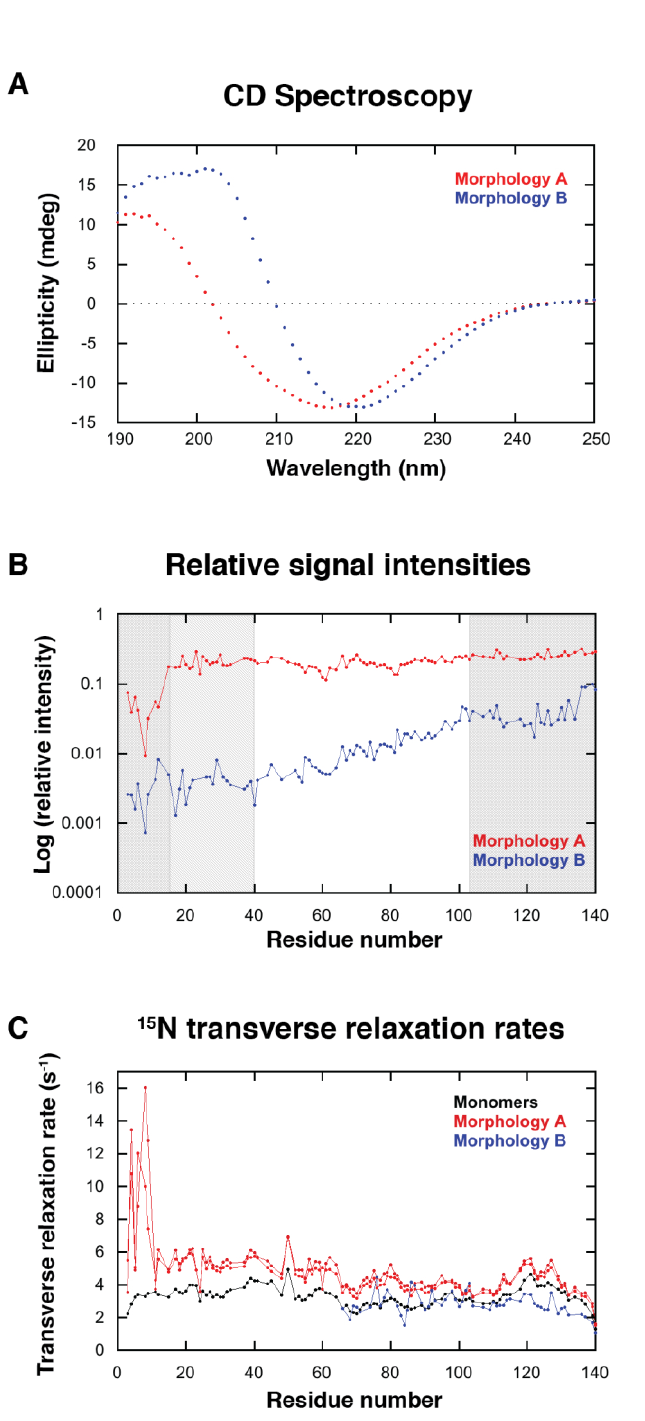
Figure 3. NMR characterization of transient monomer fibril interactions for different morphologies.